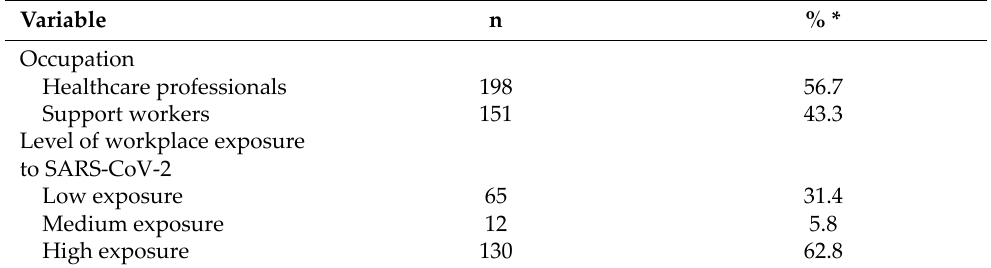
Table 4. Statuses of SARS‑CoV‑2 IgA/IgG before vaccination and vaccine scheme at the time of SARS‑CoV‑2 test in healthcare workers from